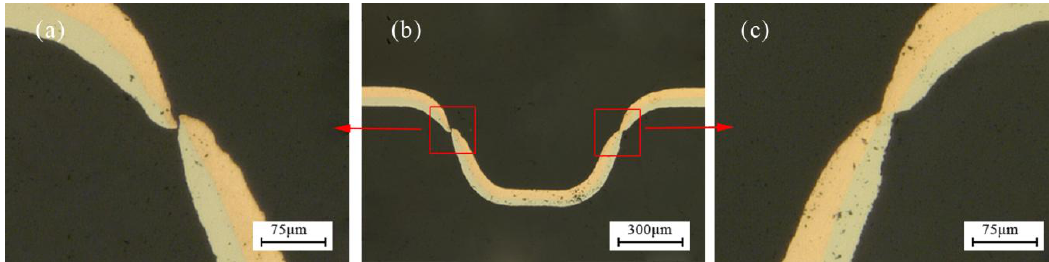
Figure 11. The necking and fracture of the workpiece: ( a ) fracture, ( b ) the overall, and ( c ) necking.